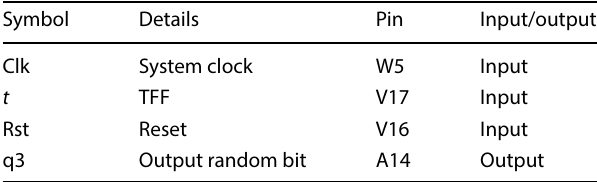
Table 4 FPGA pin details for implemented TRNG based on ADPLL